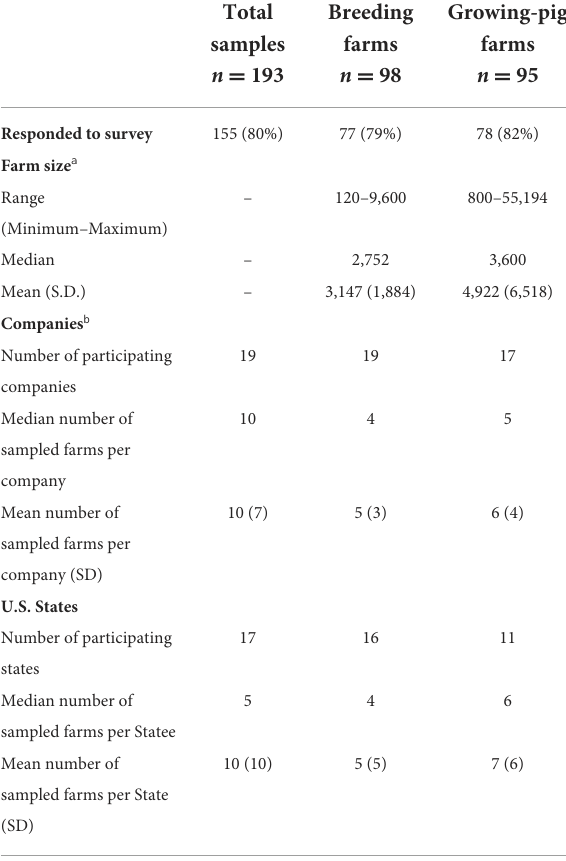
a Datafrom75and76participatingbreedingandgrowing-pigfarms,respectively. b Data from all participating production companies, veterinary clinics, and two